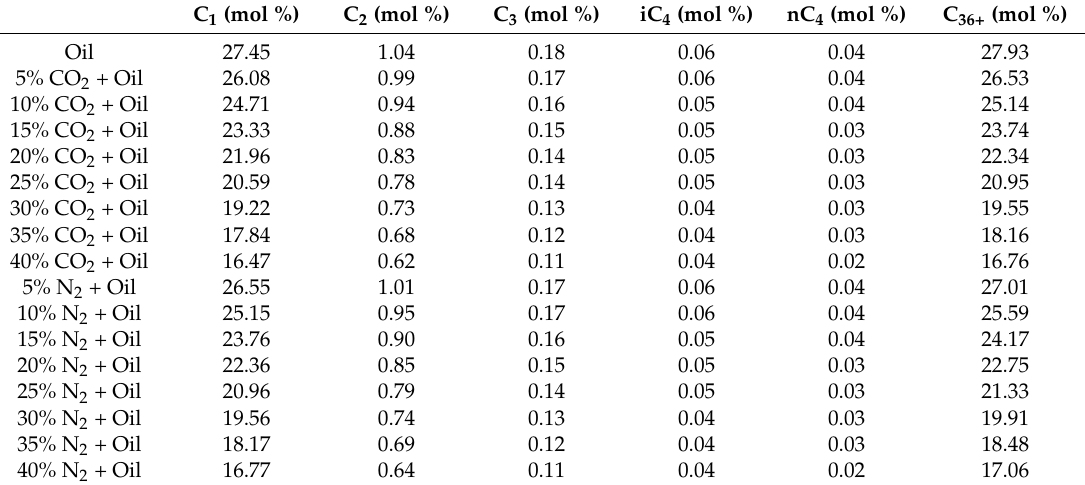
Table 3. Composition change of crude oil with different CO 2 and N 2 injection volumes in a shallow